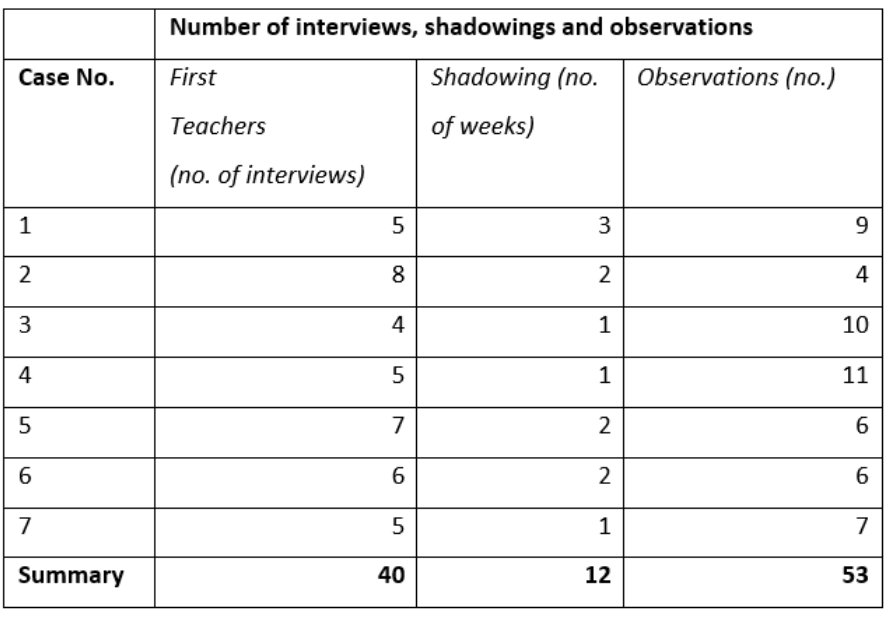
Table 1. Overview of